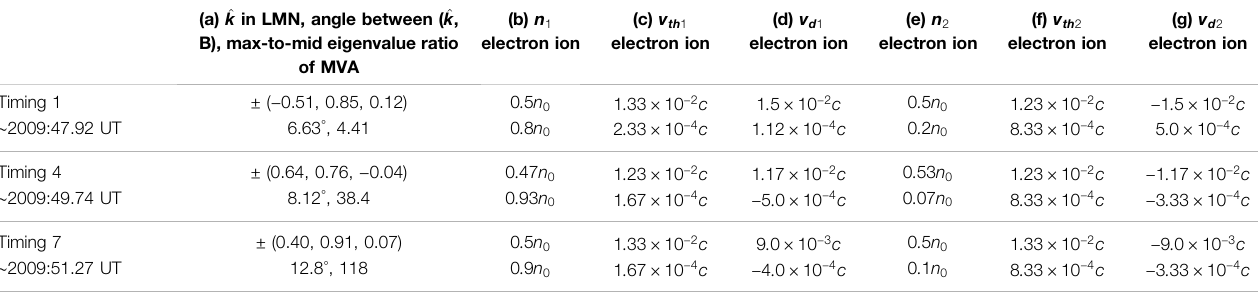
TABLE 1 | Parameters of modeled distributions used for linear analysis, where n 0 is total density and c is the speed of light. Each distribution is modeled as a sum of two Maxwellian distributions. (a) ^ k in LMN, angle between ( ^ k , B), max-to-mid eigenvalue ratio of